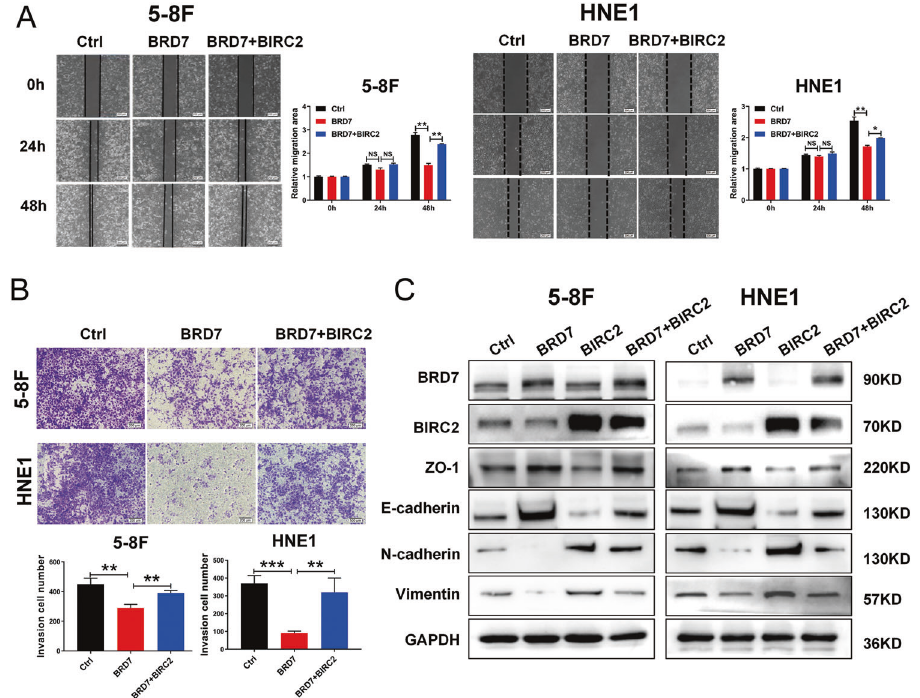
Fig. 5 Restoration of BIRC2 expression reverses the inhibitory effect of BRD7 on cell migration and invasion. A Scratch wound healing analysis of cell migration in 5-8 F and HNE1 cells stably with BRD7 overexpression, BRD7 and BIRC2 simultaneous overexpression or control. Quanti fi cation of the wound recovery rate of the three groups (right). B Matrigel invasion analysis of cell invasive capabilities in 5-8 F and HNE1 cells stably with BRD7 overexpression, BRD7 and BIRC2 simultaneous overexpression or control. C Signi fi cantly differently expressed proteins involved in EMT progression (E-cadherin, N-cadherin, Vimentin, ZO-1) in BRD7 overexpression, BIRC2 overexpression and BIRC2 restoration cells, respectively. GAPDH served as an internal control. Error bars represent the mean ± SD. *P < 0.05, **P < 0.01, ***P < 0.001. All experiments were performed in